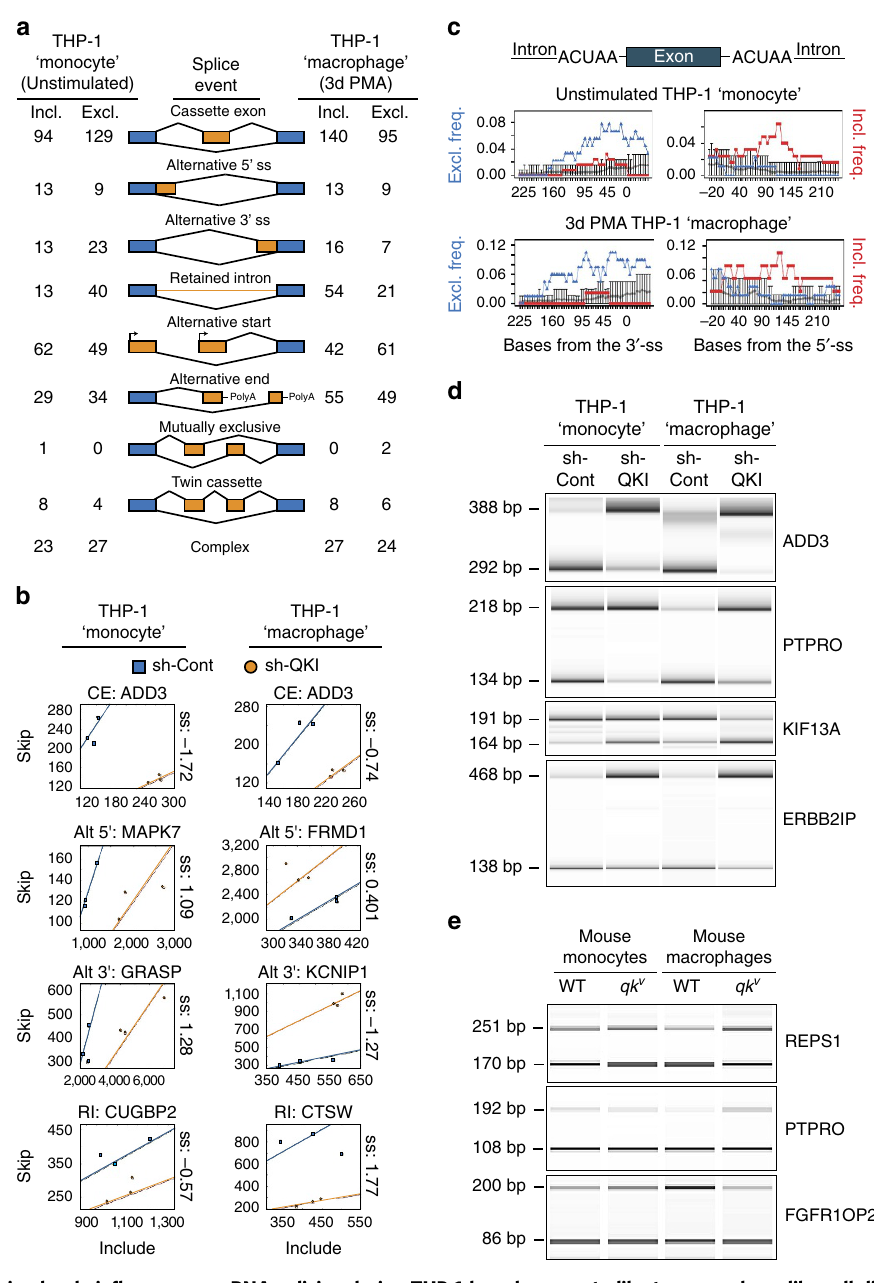
Figure 6 | QKI expression levels influence pre-mRNA splicing during THP-1-based monocyte-like to macrophage-like cell differentiation. ( a ) Schematic depicting detectable alternative splicing events with the splicing-sensitive microarray platform and number of inclusion (incl.; top lines) or exclusion (excl.; bottom lines) events observed in unstimulated THP-1 ‘monocytes’ (left) and 3-day PMA-stimulated THP-1 ‘macrophages’ ( n ¼ 3, q r 0.05). ( b ) Scatterplots of skip ( y axis) and include ( x axis) probe set intensity for selected alternative splicing events in sh-Cont (blue boxes) versus sh-QKI (orange circles) in unstimulated and 3days PMA-stimulated THP-1 ‘monocytes’ and ‘macrophages’, respectively. Regression coefficients (constrained to pass the origin) are depicted as solid lines. The log 2 difference in the slopes (termed separation score; ss) are provided to the right of the plots for each event, with for example, an ss of (cid:2) 1.72, indicating a 3.3-fold more inclusion of ADD3 exon 13 in sh-QKI versus sh-Cont THP-1 ‘monocytes’. Full event details are provided in Supplementary Data 6. CE, cassette exon; Alt 5 0 or 3 0 , alternative 5 0 or 3 0 splice site; RI, retained intron. ( c ) SpliceTrap assessment of average proximal ACUAA RNA motif enrichment in 50bp windows upstream and downstream of alternatively spliced cassette exons as compared with a background set of exons (grey circles). The relationship between the frequency of exon exclusion (blue triangles) or exon inclusion (red squares) and ACUAA RNA motif enrichment are depicted. ( d ) PCR validation of alternatively spliced cassette exons in sh-Cont and sh-QKI THP-1 ‘monocytes’ and ‘macrophages’. Primers were designed to target constitutive flanking exons. PCR product size for exon inclusion (top) and exclusion (bottom) variants are provided (left). All experiments depict biological n ¼ 3. ( e ) PCR validation of three splicing events in wt and qk v mouse-derived primary monocytes and 7 days M-CSF-stimulated macrophages. PCR product size for exon inclusion (top) and exclusion (bottom) variants are provided (left). Depicted is a representative PCR for at least a biological n Z